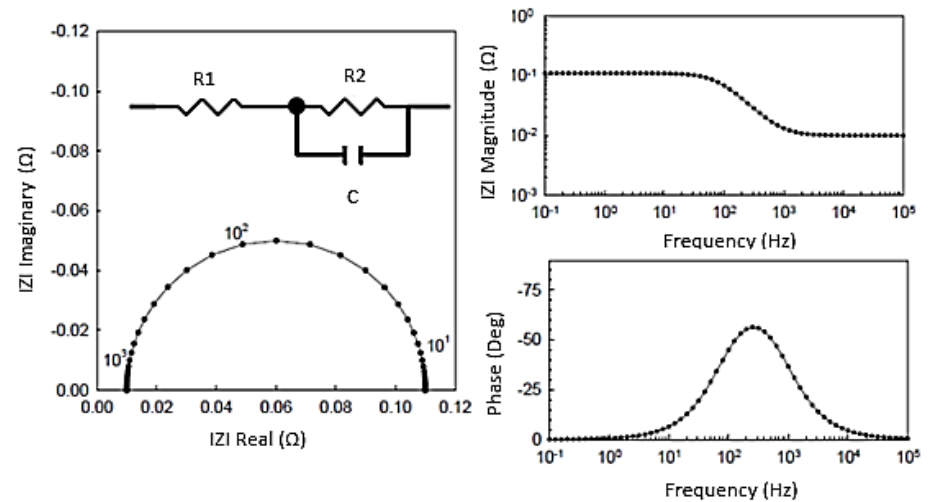
Figure 4. General impedance plots for RC circuits by using the Nyquist plot [19].